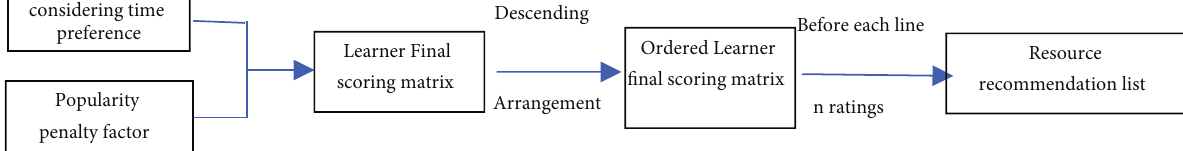
Figure 1: Book recommendation system of university library considering timeliness and popularity.